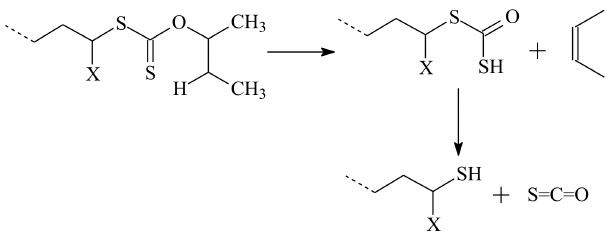
Scheme 14. The Chugaev elimination in xanthate-based